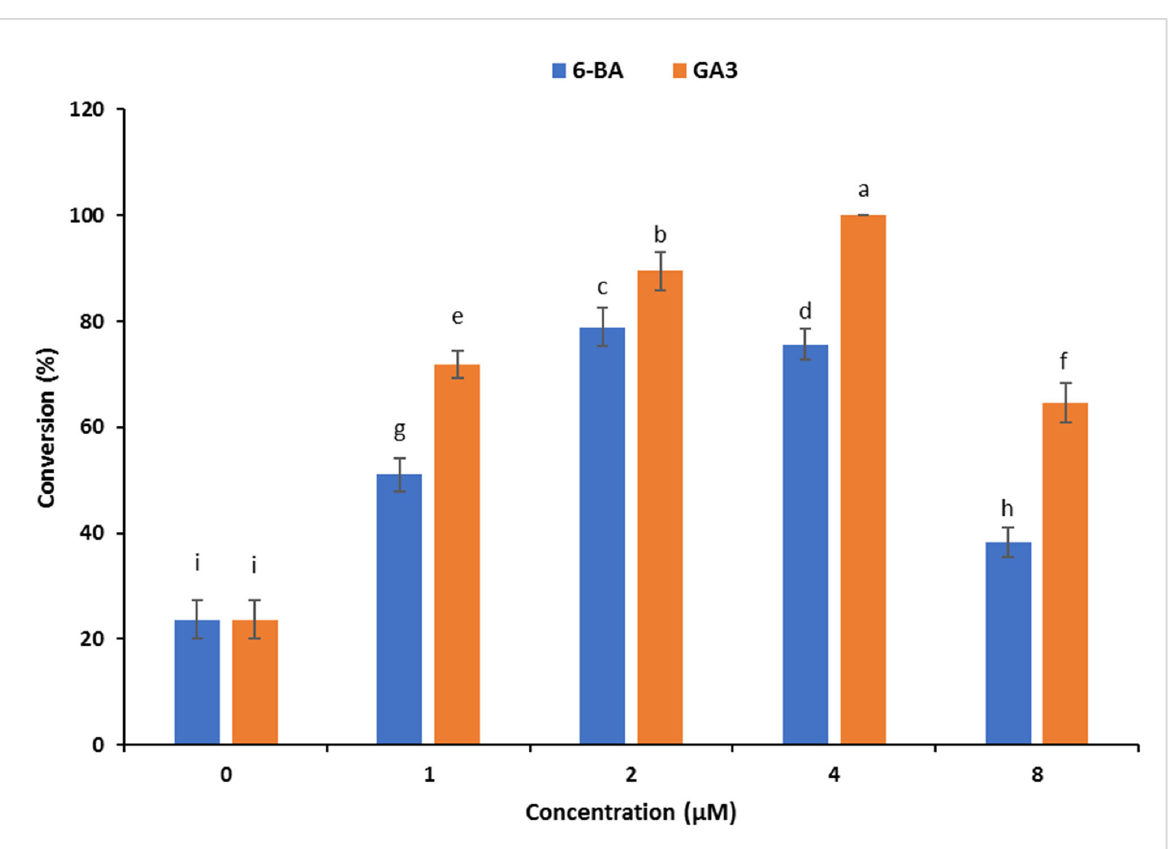
Figure 2. Effect of 6 ‐ BA and GA 3 on the conversion of C. orbiculata SoEs. The means ± SDs in each vertical bar with different alphabets (a–i) are significantly different according to DMRT at p < 0.05.